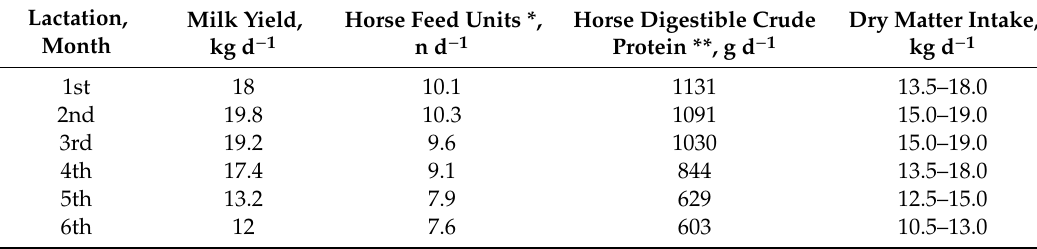
Table 3. Recommended nutrient requirements and intake for lactating mares (600 kg body weight) [93]. Lactation,